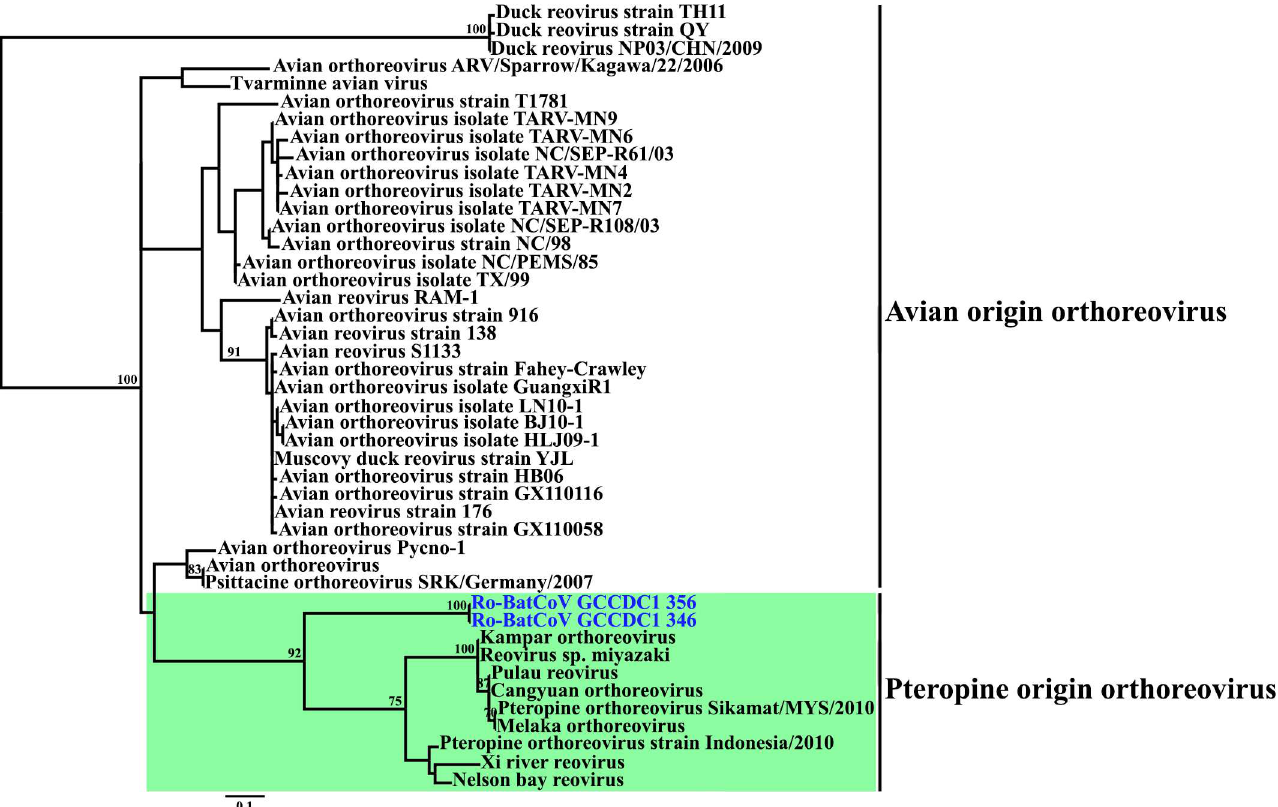
Fig 3. Phylogenetic analyses of p10 from representativereoviruses and Ro-BatCoVGCCDC1. The tree was inferred using the maximum likelihood method available in PhyML. Bootstrapvalues are shown at relevant nodes. The GenBank accession numbers used in this analysis are listed in S3 Table.